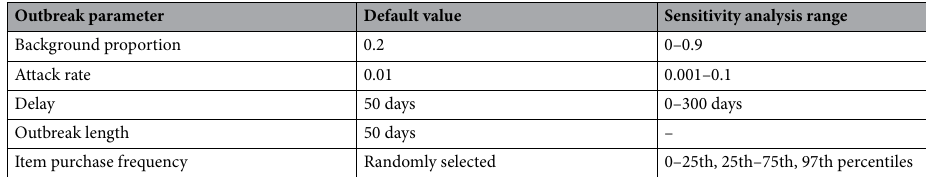
Table 2. Summary of parameters used during outbreak simulation. Unless otherwise indicated, default values were used for simulation. Sensitivity analyses were also conducted for each parameter within the ranges shown.